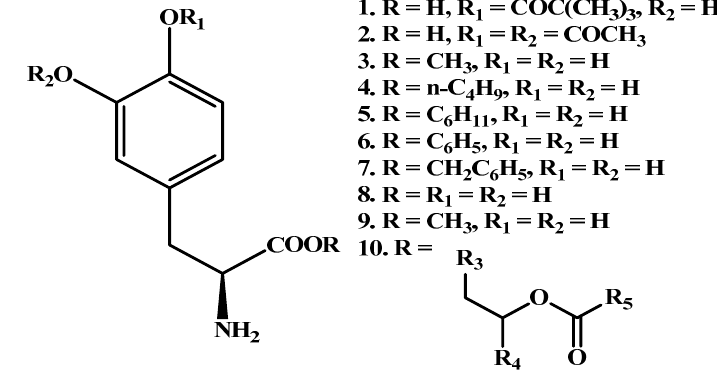
Figure 2. Chemical structures of LD ester prodrugs, 1 – 10 .